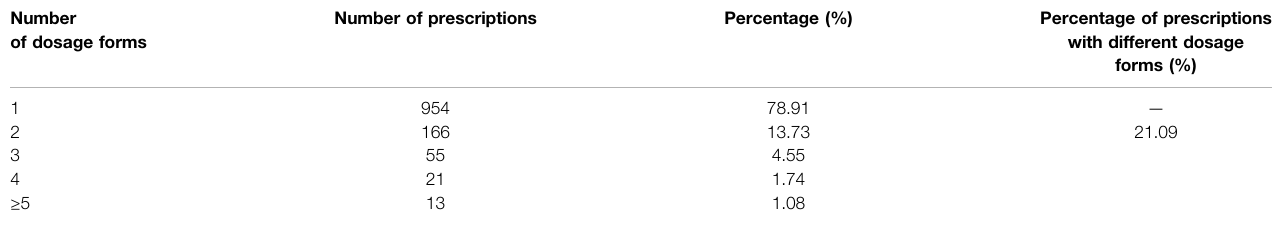
TABLE 1 | Statistics on prescriptions with the phenomenon of “ Different Dosage Forms of the Same Prescription ” in Chinese Pharmacopoeia 2020 edition. Number of dosage